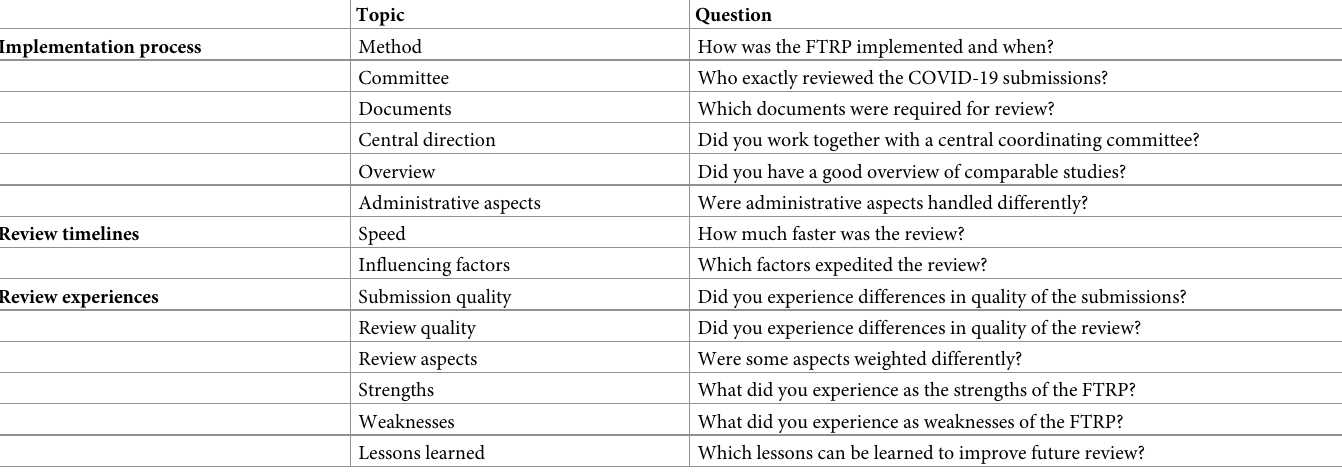
Table 2. Topic list interviews MRECs.